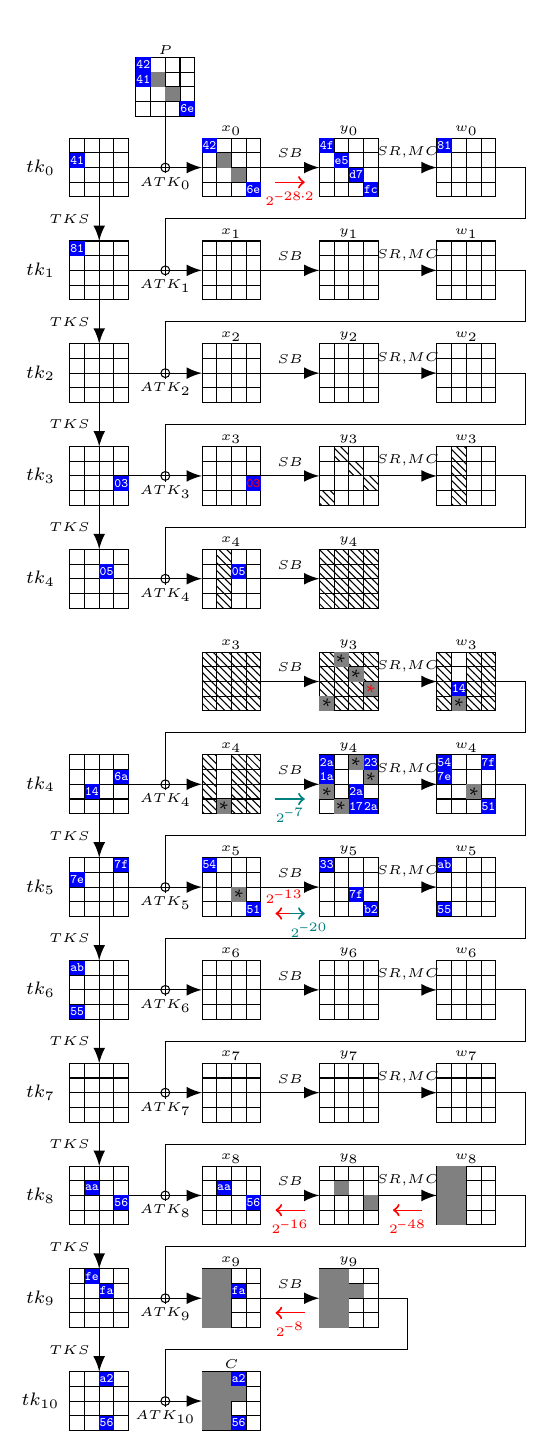
Figure 15: Truncated boomerang attack on 10-round Deoxys-BC in the RTK2 model, which is taken from Fig. 11. Truncated boomerang attack on 10-round Deoxys-BC in the RTK2 model, starting from the ciphertext side. This attack succeeds with probability 1 / 2.